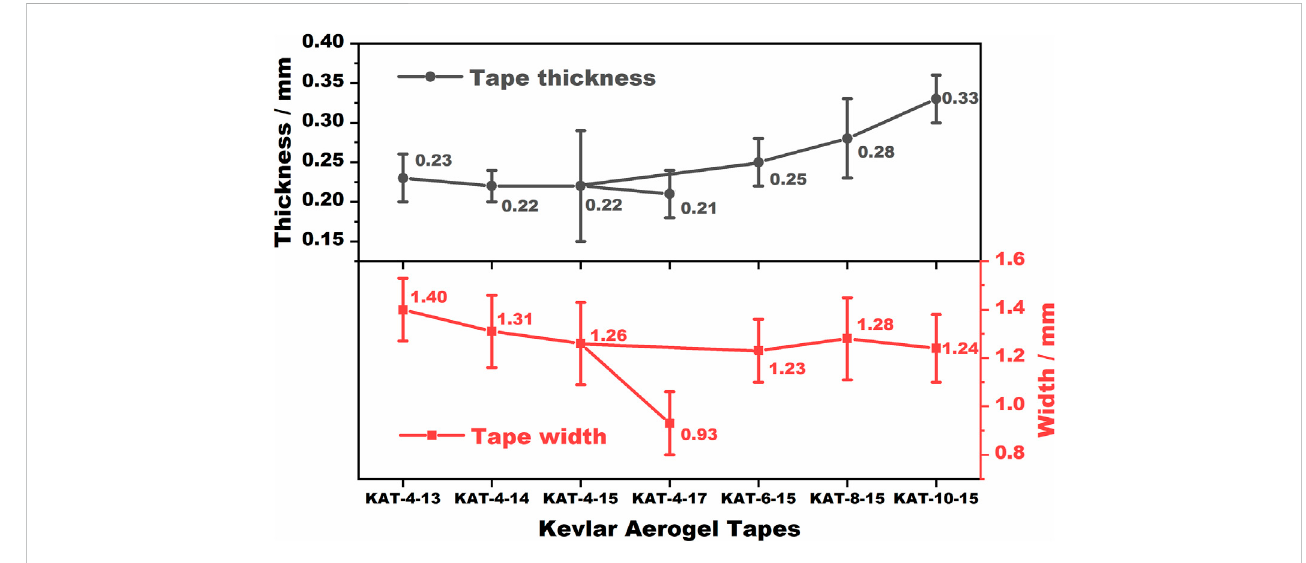
FIGURE 2 The thickness and width of the resultant aerogel tapes.